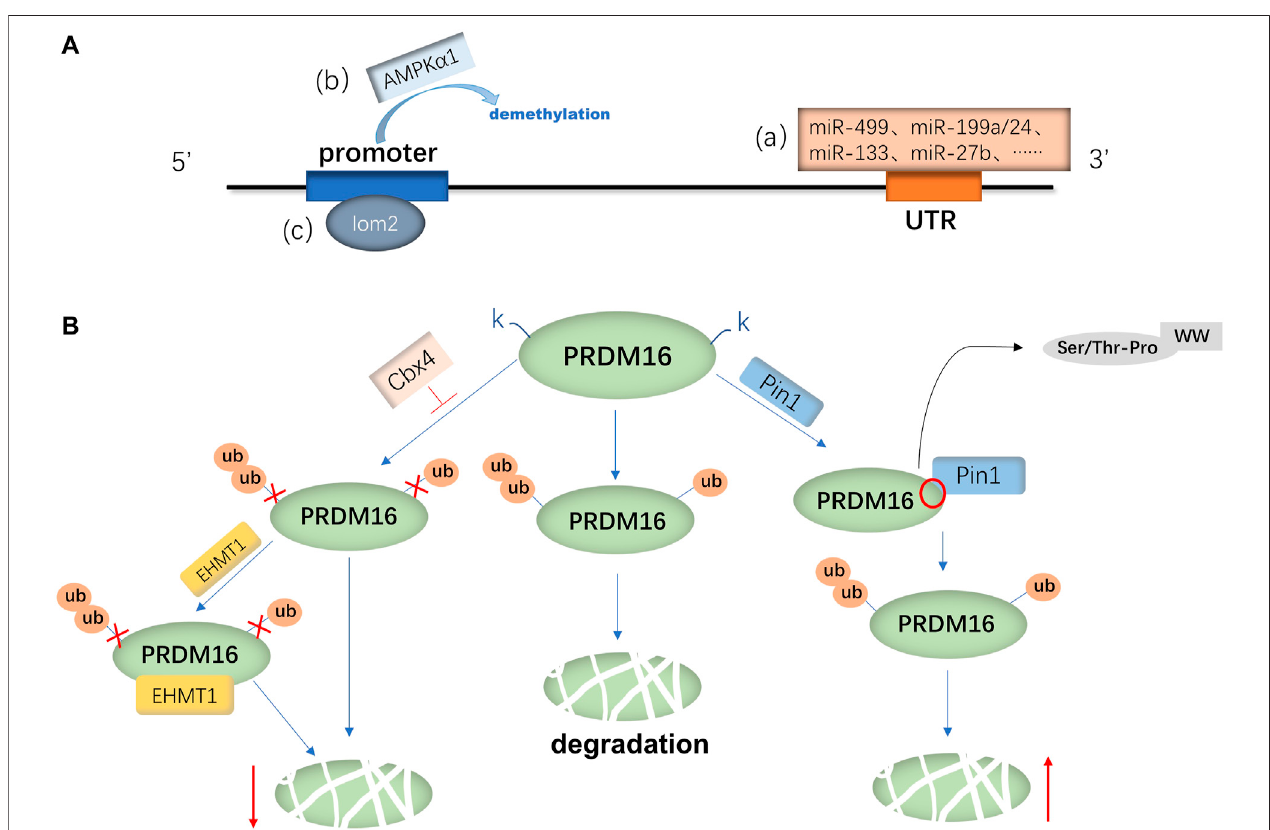
FIGURE1| RegulatorymechanismofPRDM16expression. (A) mRNAexpressionofPRDM16isprimarilyregulatedbyvariousmiRNAs(a)bindingtothe3 ′ -UTRof PRDM16 and AMPK α 1(b) and lom2(c) binding to the promoter of PRDM16. (B) PRDM16 is degraded by ubiquitination, and Cbx4 promotes the K917 site of PRDM16, which inhibits ubiquitination; moreover, EHMT1 can further inhibit degradation. On the other hand, Pin1 facilitates the ubiquitination ofthe PRDM16 protein, with its WW binding to the Ser/THR-Pro site of the PRDM16 PR domain.